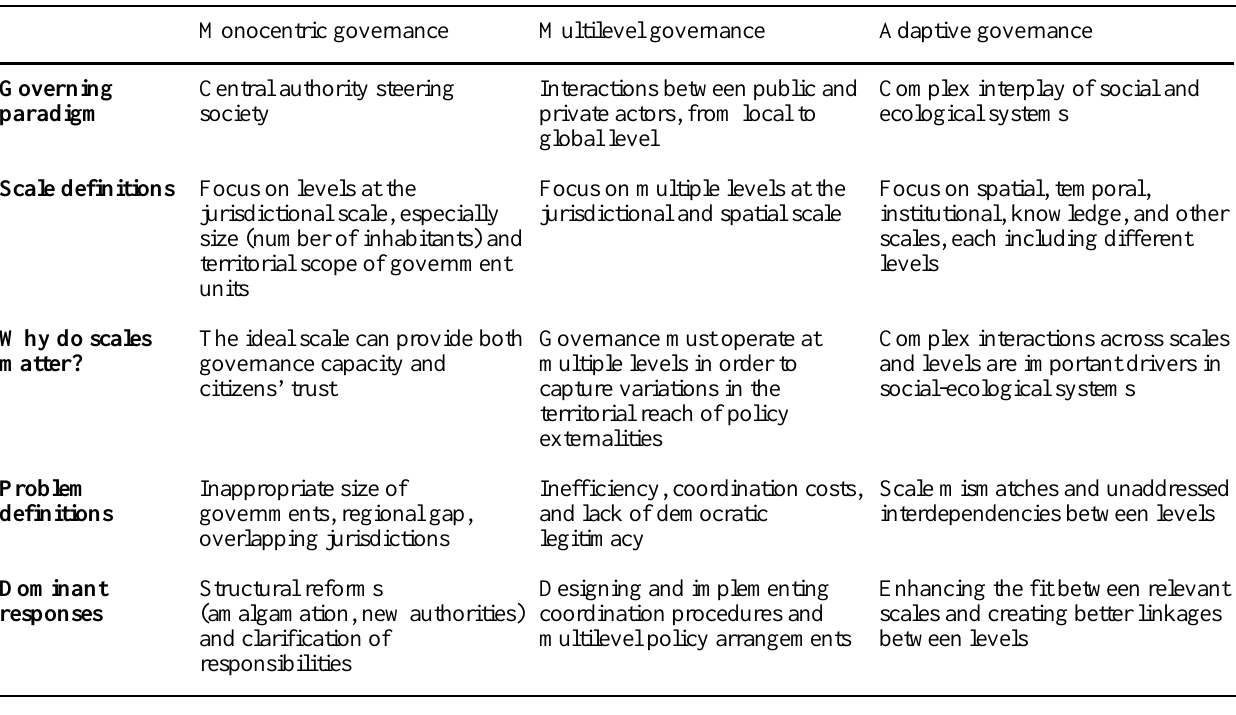
Table 1 . Comparing scale approaches in governance